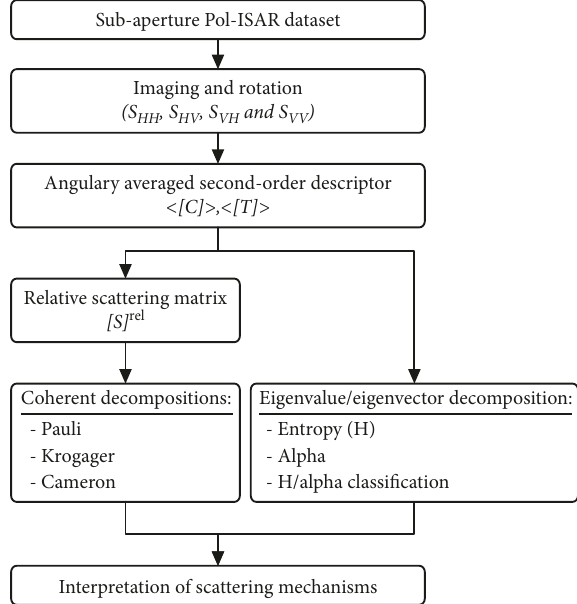
Figure 2: Methodological flow diagram of the polarimetric ana- lyses used in this